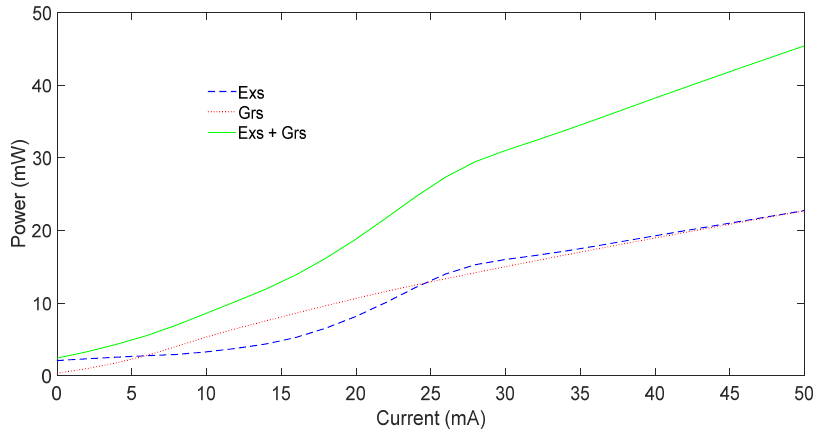
Figure 11. Output power vs. dc current under the EOGB illumination of 10 mW.